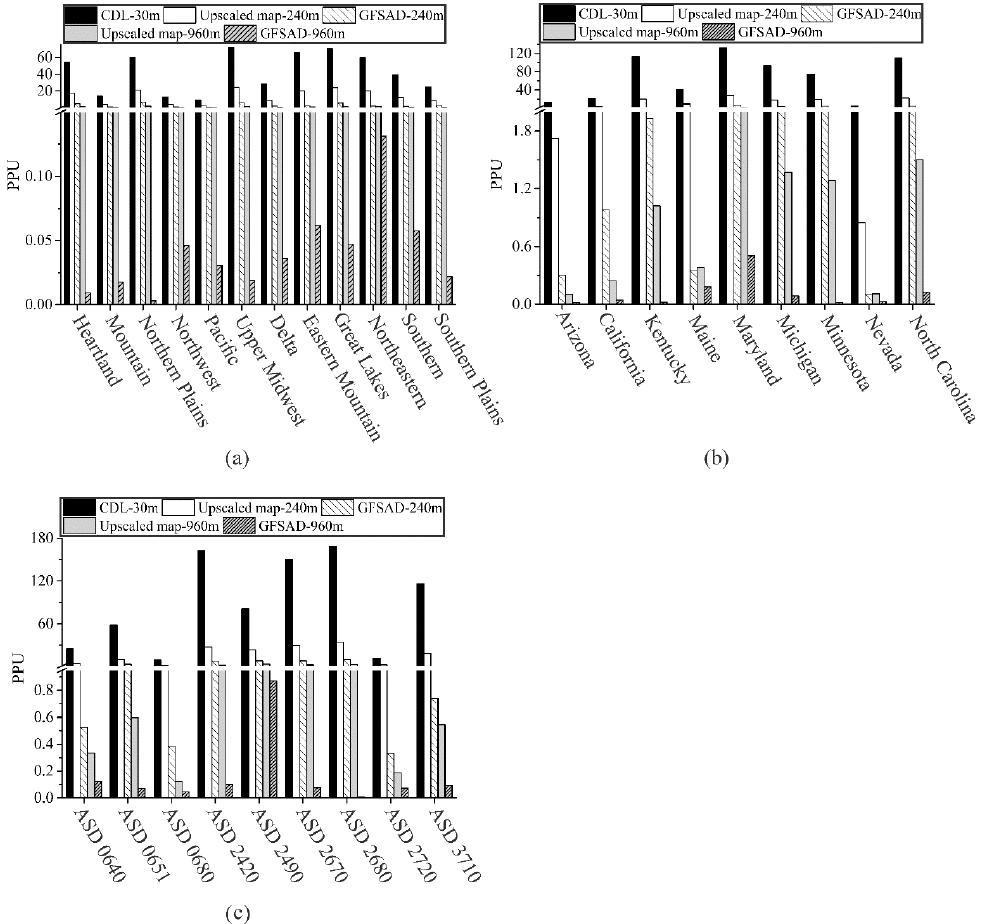
Figure 4. Comparisons of Patch-Per-Unit area (PPU) of the upscaled maps and the Global Food Security-Support Analysis Data (GFSAD) maps. ( a – c ) are the results of region level study site, state level study site, and ASD level study site, respectively. Note that CDL-30 m represents the crop/non-crop map derived from CDL data at 2010.